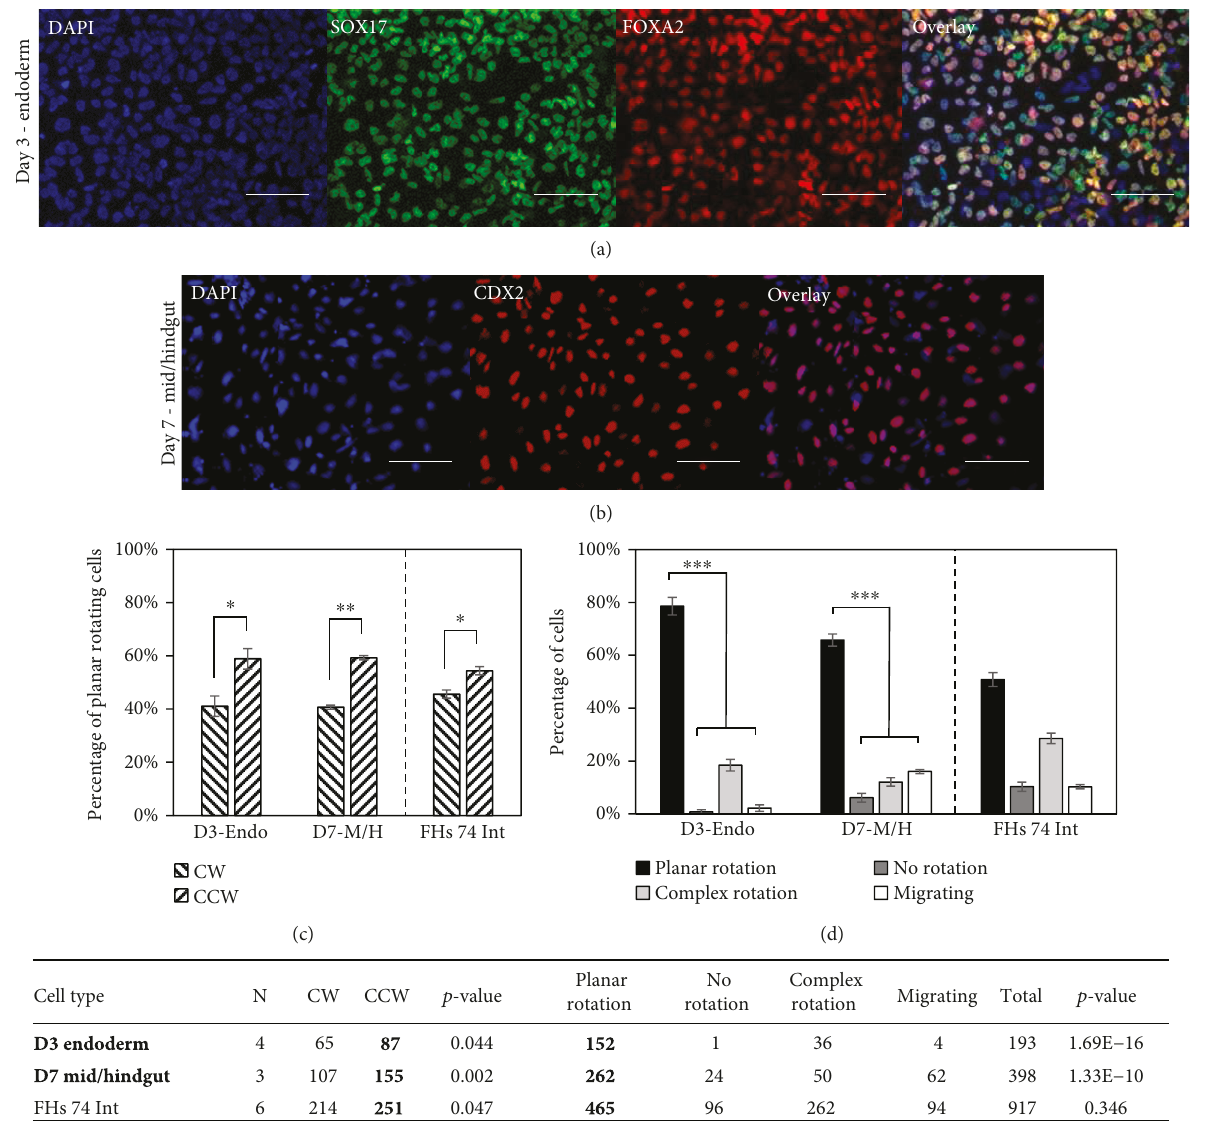
Figure 3: Human ESCs di ff erentiated to an intestinal lineage display dominant CCW biased rotation, which is comparable to an intestinal cell line. (a) Representative images of cells expressing the SOX17 and FOXA2 markers indicating endoderm di ff erentiation. (b) Representative images of cells expressing an CDX2 marker indicating mid/hindgut di ff erentiation. (c) Endoderm (D3-Endo), mid/hindgut (D7-M/H), and the primary small intestinal cell line (FHs 74 Int) all display statistically signi fi cant CCW rotational bias. (d) Endoderm and mid/ hindgut show signi fi cantly more planar rotating cells than other categories; however, the FHs 74 Int cell line does not. (e) Quantitative data showing the number of cells in each category along with the number of replicate experiments ( N ). The p values indicate comparisons between CW and CCW and between planar rotation and the other three categories. Scale bars: 100 μ m; ∗ p < 0 05 ; ∗∗∗ p < 0 01